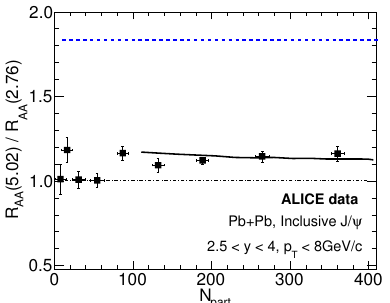
Figure 3. The ratio of inclusive nuclear modification factors R AA at 2.76 TeV and 5.02 TeV Pb- Pb collisions, plotted with a black solid line. The blue dotted line is a situation where the same hydrodynamic evolution is used as a test in both collision energies. The reduction from dotted to black solid lines is due to the stronger diffusion of charm quarks in the hotter medium produced at 5.02 TeV. This figure is cited from Ref.